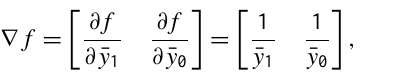
Fig. A1. Comparison of the proportional loss (PL) function of Model I (evaluated at V = 7ms − 1 ) with the best-fitting PL func- tions of Totschnig et al. (2011: Eq. 7) and Totschnig and Fuchs (2013, Eq. 3). PL is the proportional